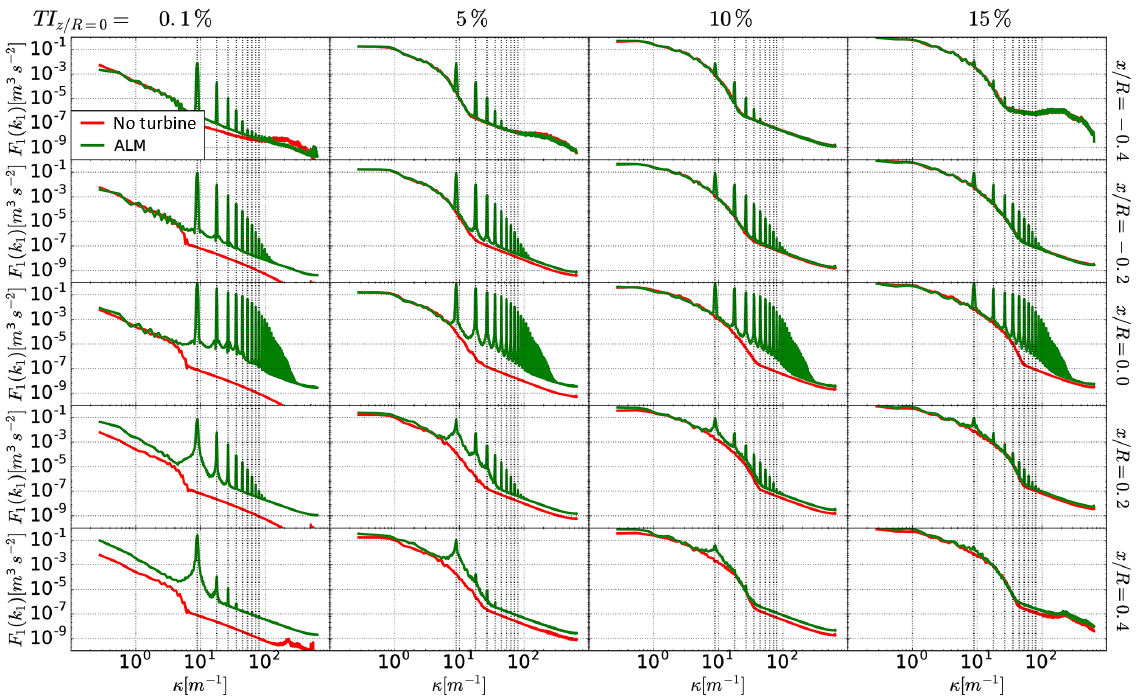
Figure 17. The energy spectra for the shear layer flow based on the time series of the axial velocity component at different points in the near wake ( x/R = {− 0 . 4 , − 0 . 2 , 0 , 0 . 2 , 0 . 4 } ) for different inlet turbulent intensities T syn = { 0 . 1 , 5 , 10 , 15 } % at hub height z/R = 0 . 0 are shown. The impact of the rotor presence can be seen by the spikes at the wavenumber 3 times the rotor frequency and its higher harmonics (dotted black